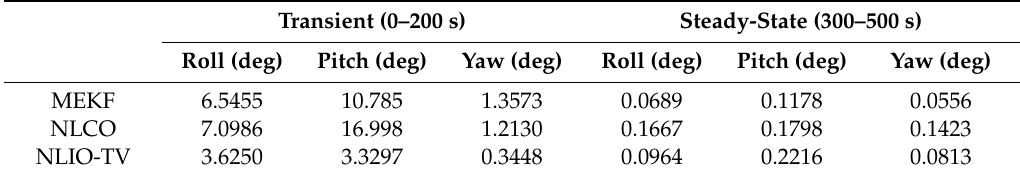
Table 7. RMSEs of attitude for all